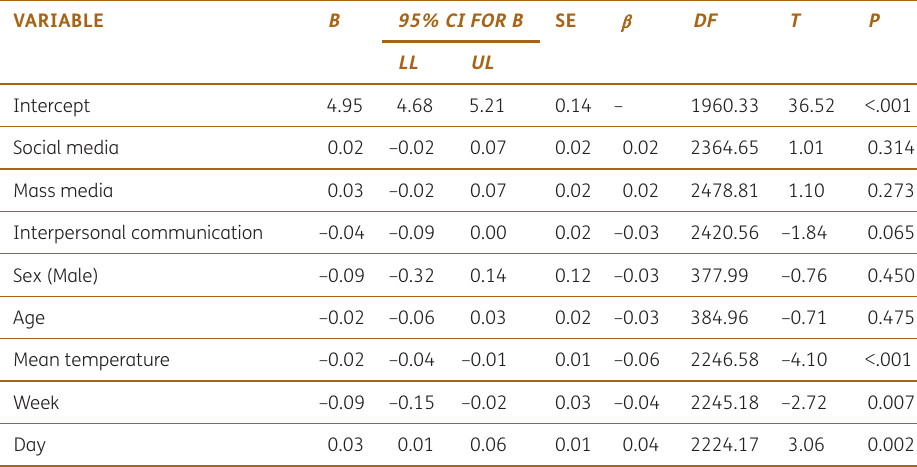
Table 7 Multivariate Linear Mixed-Effects Model Predicting Physical Distancing Behavior in the University Sample. Note : N = 380. ICC = .59. Marginal R 2 = .01. Conditional R 2 = .59. Participant